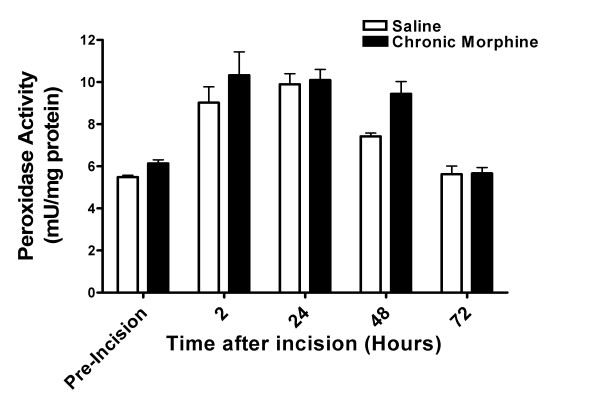
Myeloperoxidase (MPO) activity after hind paw incisions. For these experiments MPO activity was measured in peri-incisional skin as an index of infiltrating neutrophil activity. Skin was harvested from separate groups of mice at the indicated time points and processed for MPO assays as described in Methods. The time course for analysis was the same as that used for the behavioral and cytokine assays. Statistical analysis failed to detect between group differences at any of these time points. N = 8/group.